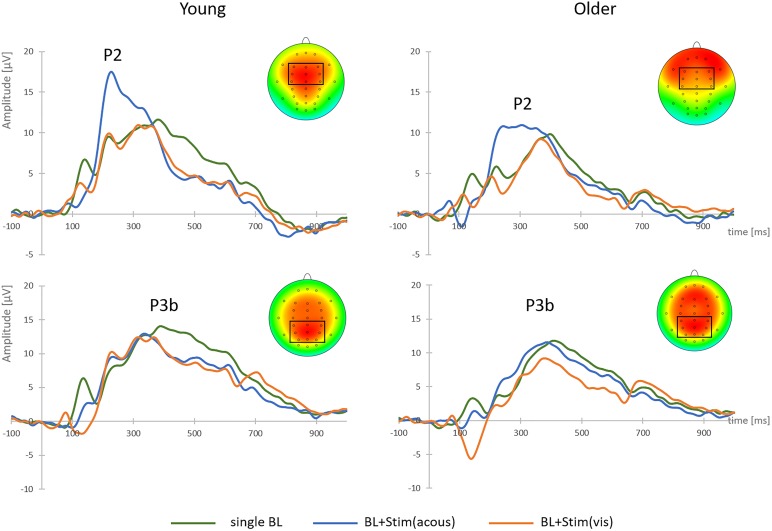
Grand-average target-locked P2 and P3b components and brain topographies to single brake lights (BL), brake lights with secondary acoustic stimulus [BL + Stim(acous)] and brake lights with secondary visual stimulus [BL + Stim(vis)] in the perception task, shown at FCz (P2) and Pz (P3b), separately for young and older participants. The clusters of fronto-central and parietal electrodes for P2 and P3b analyses are marked.